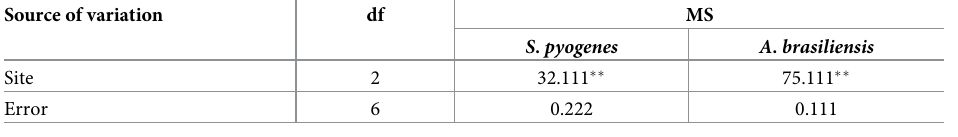
Table 9. ANOVA related to the effect of crop site on IZD of R . damascena EO for some standard microbial strains. Source of